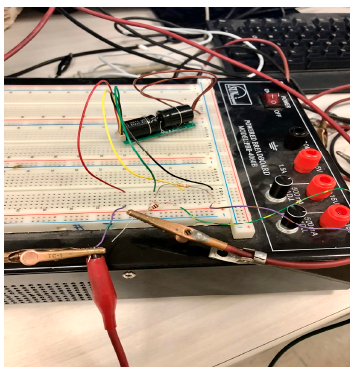
Figure 2. Energy Harvesting Module Test Circuit.